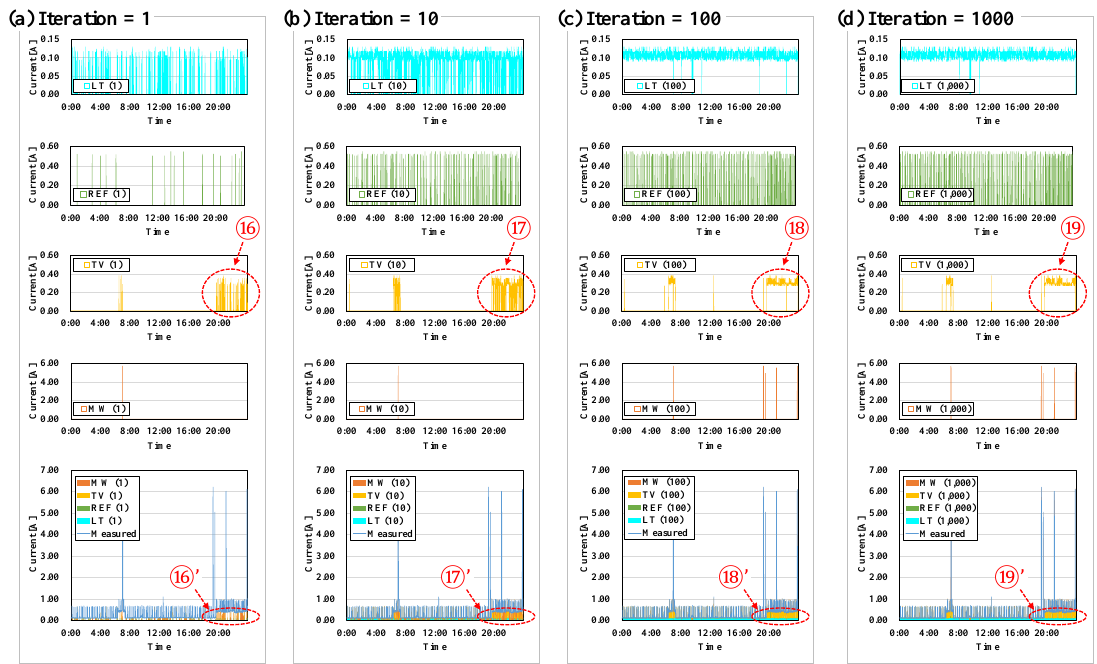
Figure 11. Load disaggregation outcomes (1 November) according to number of iterations: ( a )